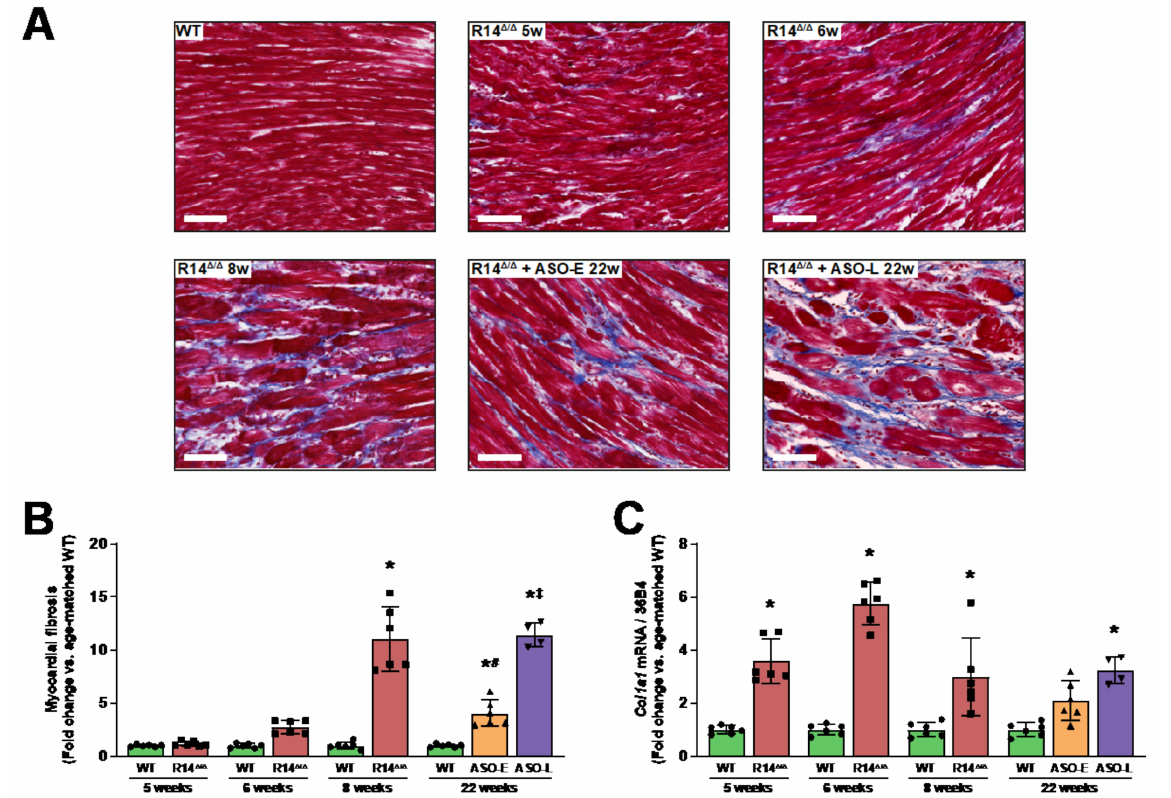
Figure 4. Myocardial fibrosis formation was attenuated upon PLN-ASO administration. ( A , B ) Representative images of Masson’s trichrome-stained cardiac tissue sections (scale bar: 70 µ m) ( A ) and quantification of myocardial fibrosis in WT mice and vehicle-treated or early or late ASO- treated PLN-R14 ∆ / ∆ mice at the age of 5, 6, 8 or 22 weeks, depicted as fold change compared to age-matched WT mice ( B ). ( C ) Left-ventricular mRNA levels of Col1a1 (collagen, type I, alpha I; COL1A1) normalized to housekeeping gene Rplp0 (36B4) mRNA levels in WT mice and vehicle- treated or early or late ASO-treated PLN-R14 ∆ / ∆ mice at the age of 5, 6, 8 or 22 weeks, shown as fold change compared to age-matched WT mice. n = 6 per group, except n = 4 for PLN-R14 ∆ / ∆ + ASO-late. Data are shown as mean ± SD. * p < 0.05 vs. age-matched WT mice, # p < 0.05 vs. 8-week-old PLN-R14 ∆ / ∆ + vehicle, ‡ p < 0.05 vs. PLN-R14 ∆ / ∆ + ASO-early (two-way ANOVA and Tukey’s post hoc